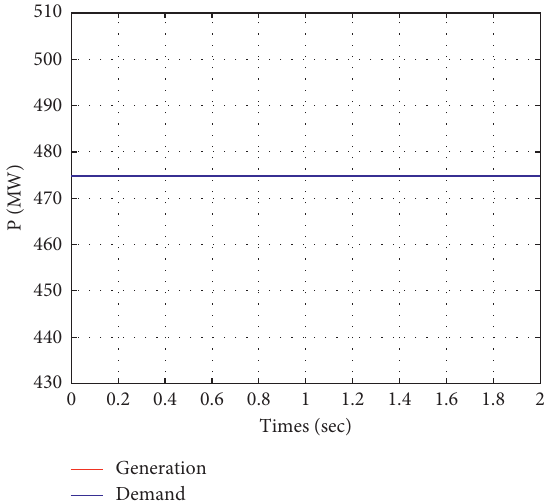
Figure 12: Totalpowerdemandofgeneratorwiththevalvepointeffect. i with power gener-